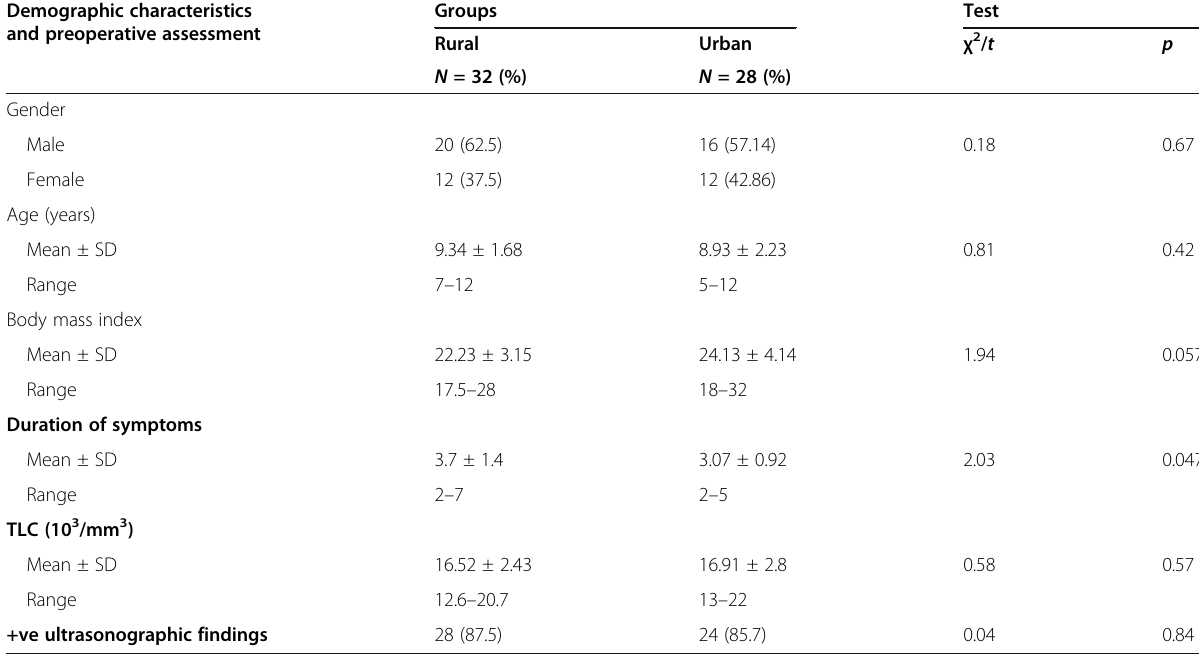
Table 1 Personal characteristics and preoperative assessment Demographic characteristics and preoperative assessment